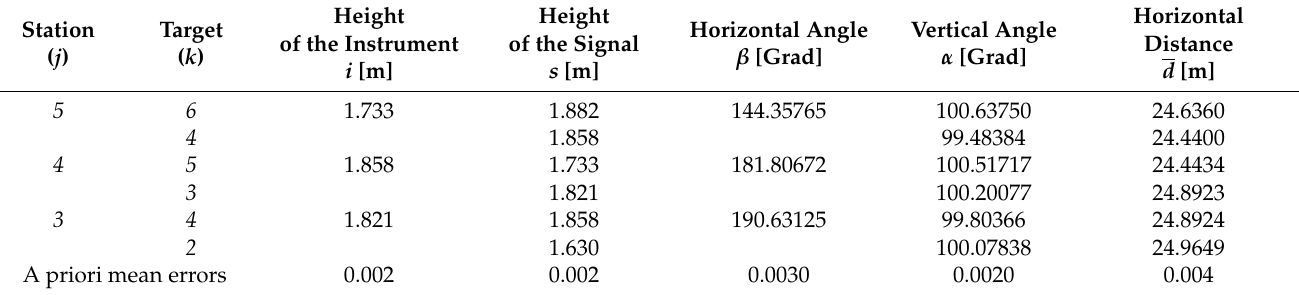
Table 3. Classical measurements (total station) and their mean errors.